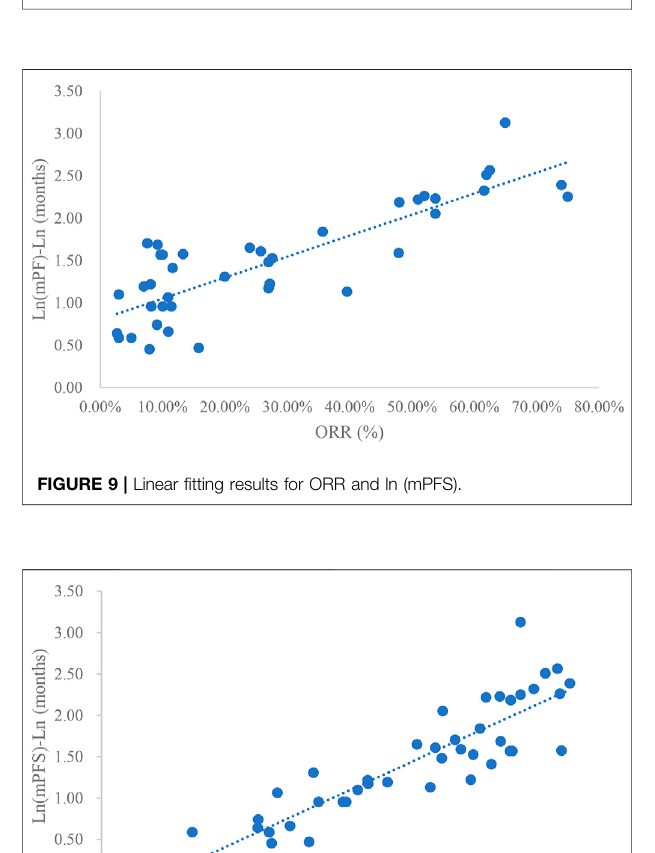
FIGURE 8 | Linear fi tting results for mPFS and mOS.